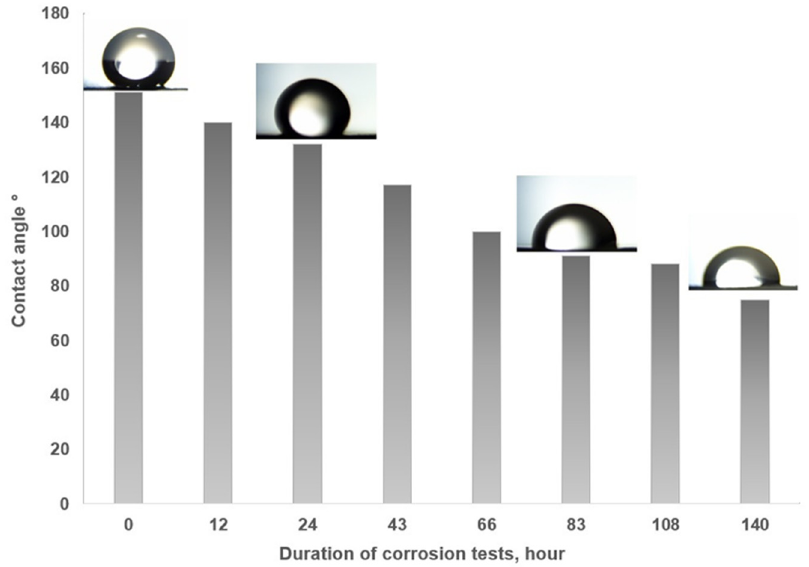
Figure 3. Plot of the wetting angle of a hydrophobized aluminum alloy versus the corrosion test duration in a salt fog chamber.